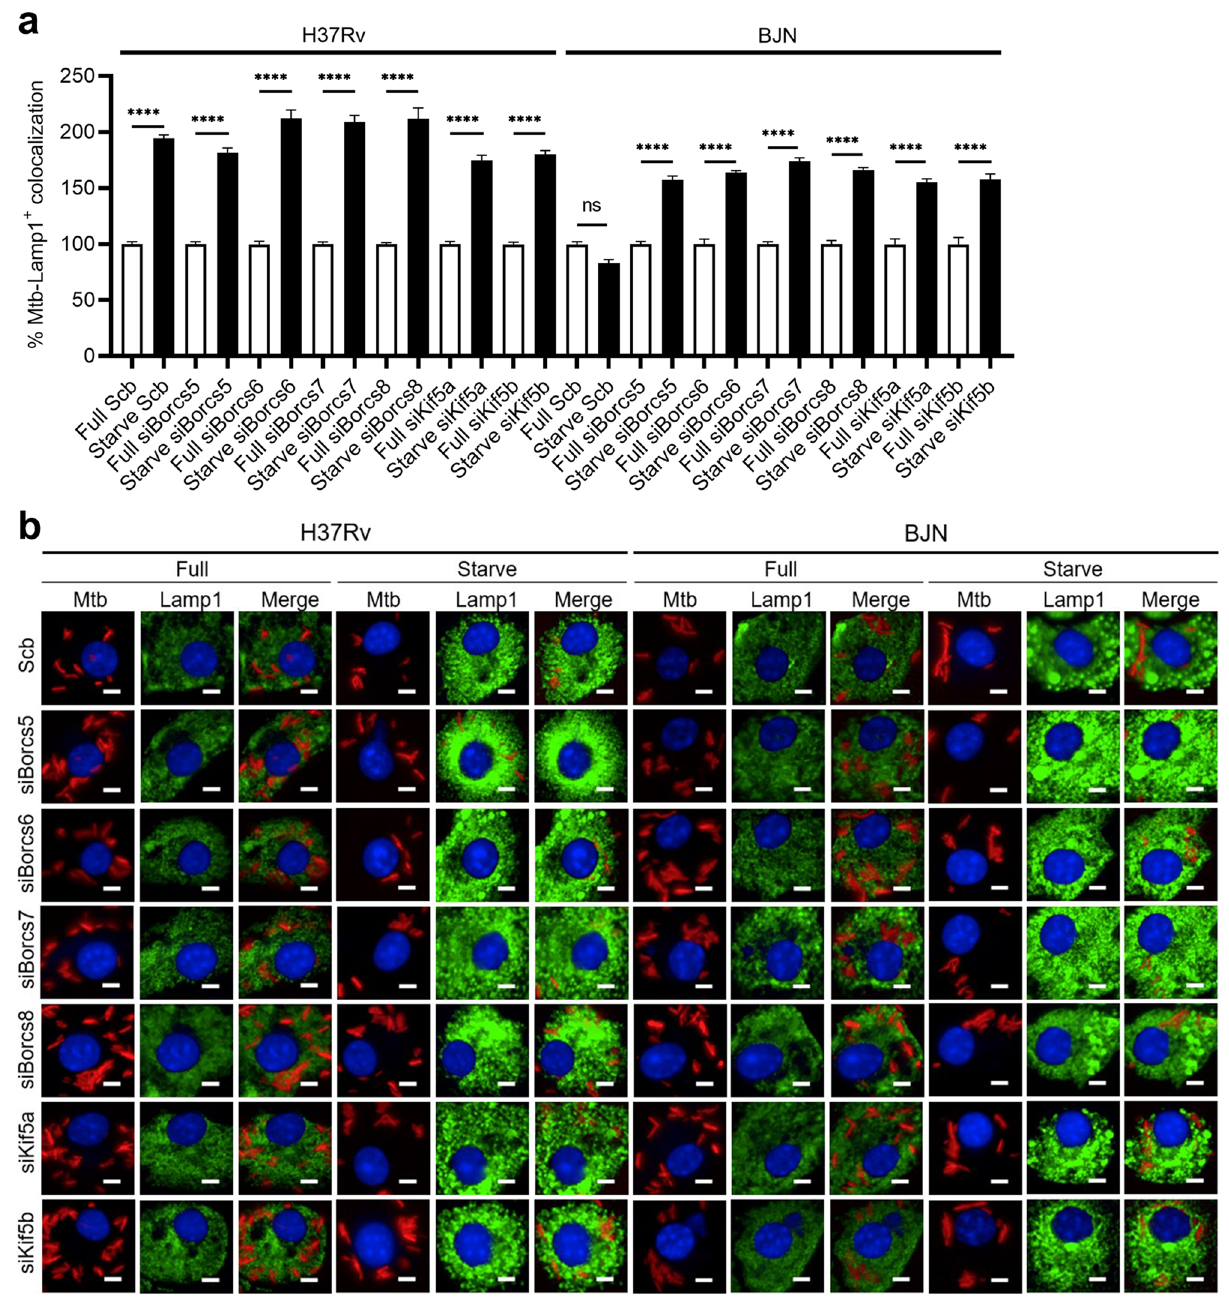
Figure 4. BORCS5-8 and Kinesin-1 suppress lysosome delivery to the BJN phagosomes in BMDMs. ( a,b ) BMDMs deficient in BORCS5-8 and Kinesin-1 expression were infected with the mCherry-expressing H37Rv or BJN and induced to undergo autophagy by starvation, as in Fig. 2. Cells were fixed and stained for lysosomes using an anti-Lamp1 antibody followed by nuclear staining with Hoechst. Percent mycobacteria-Lamp1 colocalisation was then analysed by high-content image analysis. Data are means ± SEM from at least three independent experiments; ns, non-significant and ****p < 0.0001, all relative to the full control set of 100% determined by one-way ANOVA with Tukey’s multiple comparison test ( a ). Representative images are displayed in ( b ). Bar 5 in BORCS5-8 and Kinesin-1 expressions infected with different mycobacteria induced to undergo autophagy by starvation were analysed by high-content imaging. The total number of lysosomes dispersed across the vari- ous sub-cytoplasmic areas was quantified. The illustration from the high-content imaging analysis of Lamp1 + lysosomes is shown in Supplementary Fig. S4. The border and nucleus of each infected cell were first deter- mined, and the cytoplasmic areas were then subdivided into 0, 4, 8, 12, 16, and more than 20 μm distance from the nucleus. Subsequently, the number of lysosomes in each subarea was quantitated and the sum of lysosome